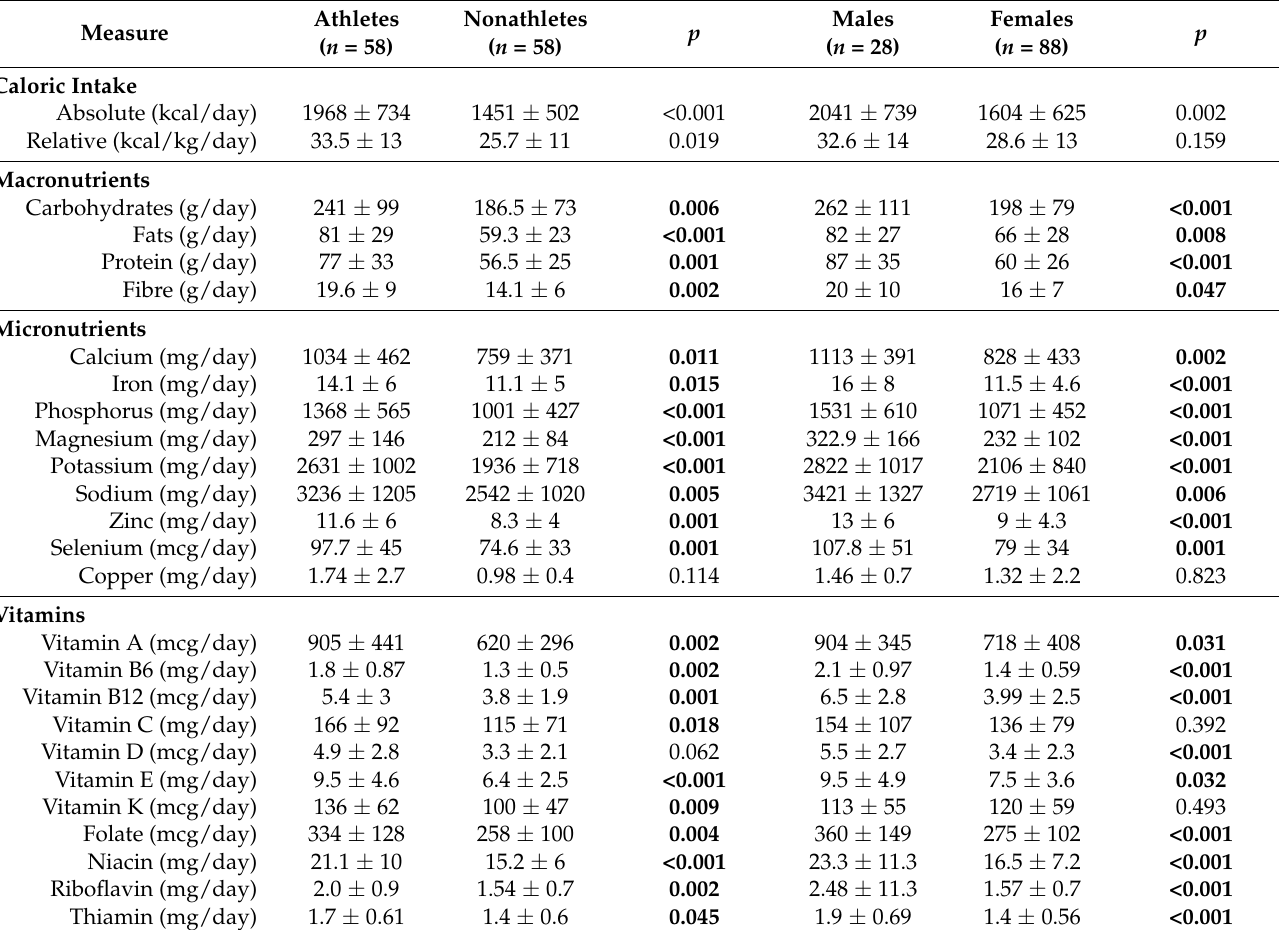
Table 3. Caloric intake, macronutrients, micronutrients, and vitamins are shown in athletes and nonathletes, and males and females. ( n = 116). Values are means ± SD. Bolded p values are